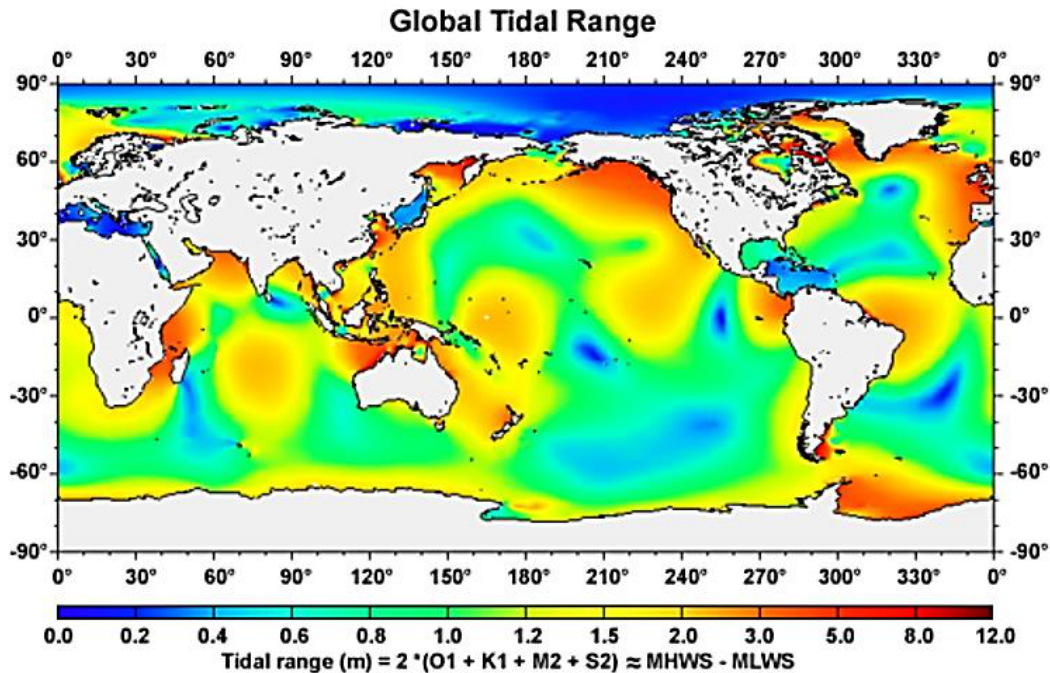
Figure 3. Tidal range, in m, around the world (Reproduced with permission from [47]. University of Graz Wegener Center for Climate and Global Change, 2019).